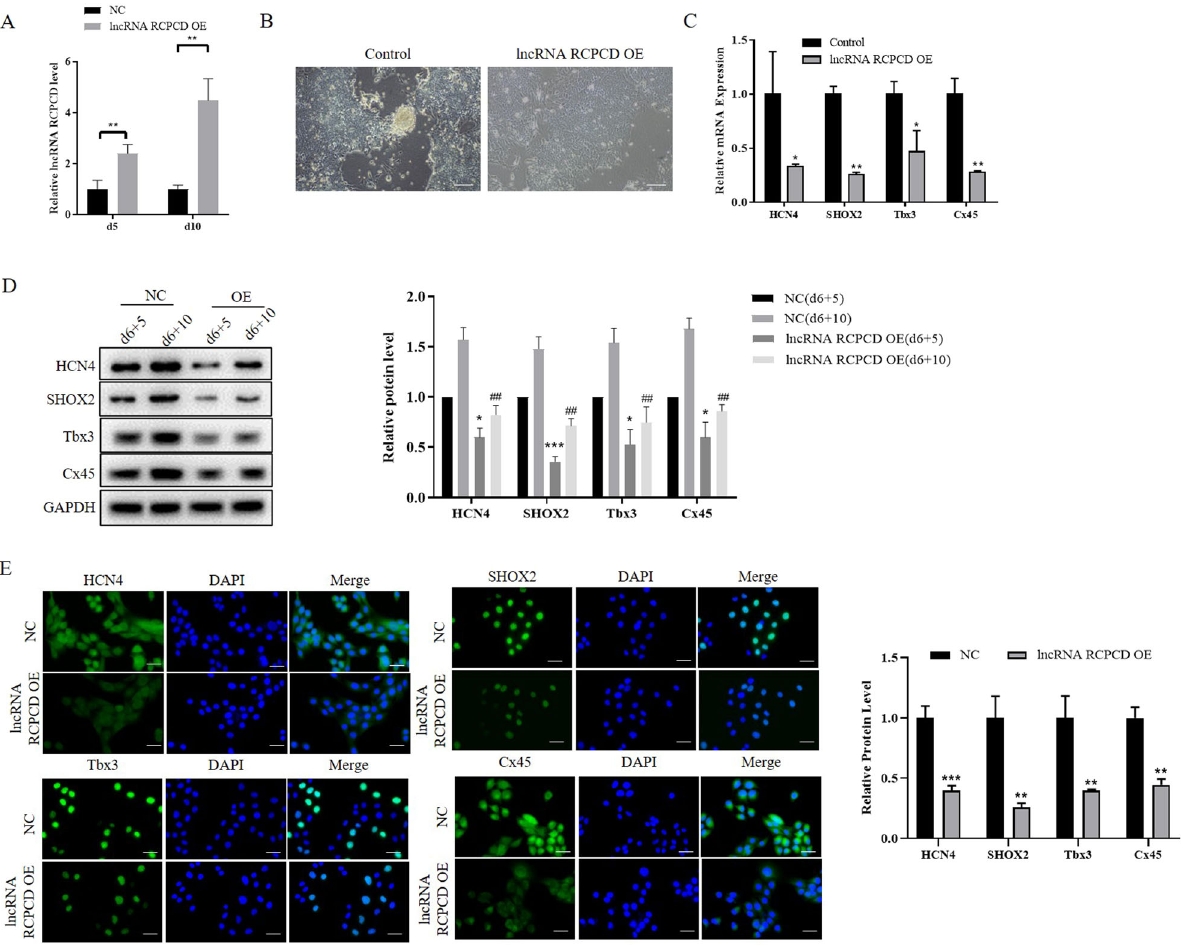
Fig. 3 Overexpression of lncRNA RCPCD suppressed the differentiation of ESCs into pacemaker-like cells. ESCs were cultured in a differentiation medium to form pacemaker-like cells. RCPCD adenovirus and control adenovirus were transfected into ESCs when cultured 3 days and 6 days. A qRT-PCR detected the expression of RCPCD in differentiated ESCs at d6 + 5 and d6 + 10. B Cell morphology of differentiated ESCs at d6 + 10. C qRT-PCR detected the expression of pacemaker-related genes in differentiated ESCs at d6 + 10. D Western blot detected the expression of pacemaker-related genes in d6 + 5 and d6 + 10 differentiated ESCs. E IF was used to detect the expression of HCN4, Cx45, SHOX2, and Tbx3 in differentiated ESCs at d6 + 10. * P < 0.05, ** P < 0.01, *** P < 0.01, * as the difference that compared with the control group ESCs at d6 + 5 and d6 + 10. ## P < 0.01, # as the protein levels difference that compared with control group ESCs at d6 + 10. Error bars were represented the mean ± SD in triplicate